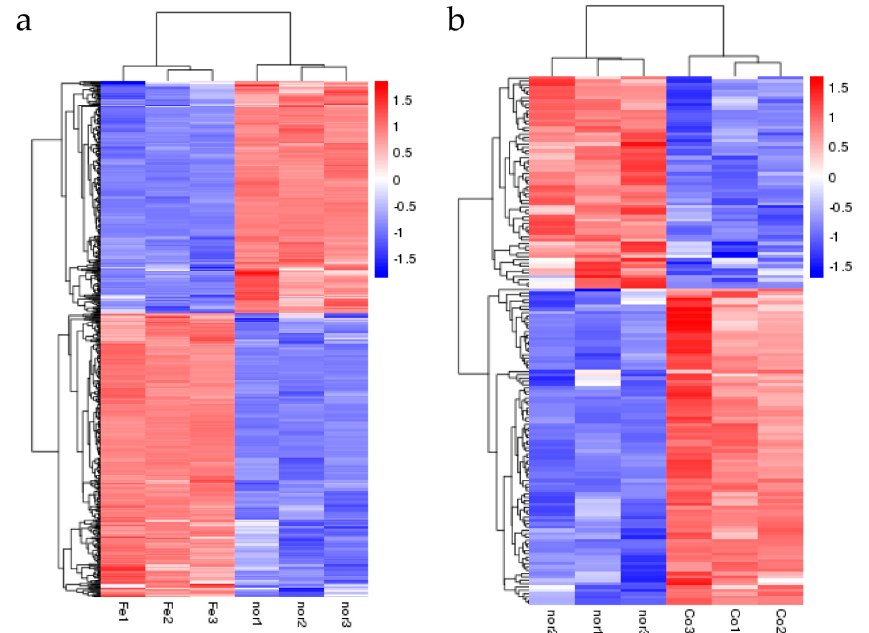
Figure 2. Cluster analyses of the DEGs in response to ferrous iron ( a ) and cobalt ( b ) toxicity based on the FPKM (the expected number of fragments per kilobase of transcript sequence per million base pairs sequenced) values. Fe1-3, Co1-3, and nor1-3 represent the three biological replications of ferrous iron, cobalt, and water treatment, respectively. The color gradient from blue to red represents relative gene expression levels from low to high.